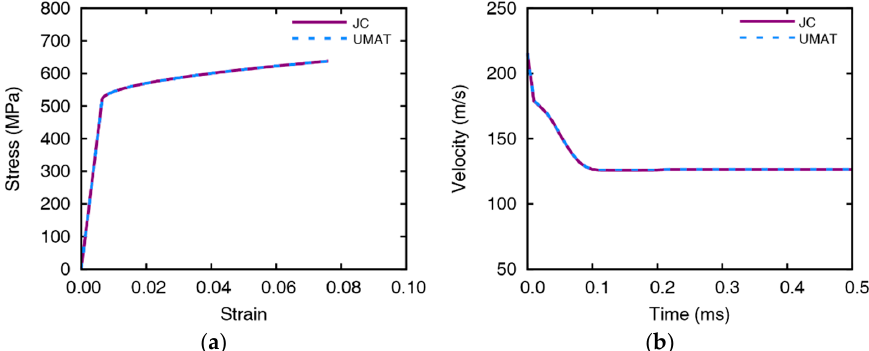
Figure 10. Comparison between the Johnson-Cook model and UMAT: ( a ) stress-strain curves of the tensile simulation and ( b ) residual velocities of the impact simulation with a 10 mm thick aluminum plate and 264.9 m/s of the initial velocity.